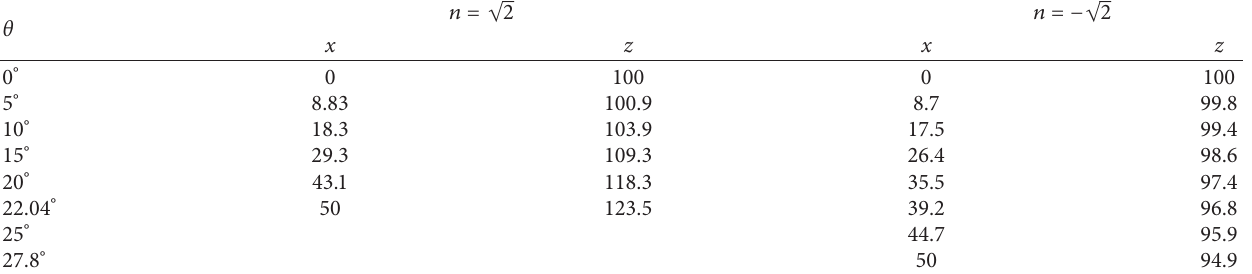
Table 1: Points on curve lens surface ( F � D � 100 mm).